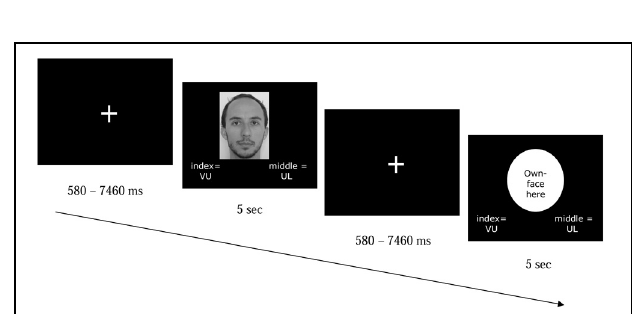
FIGURE 2 | Example of two trials of the task participants performed in the scanner. Participants were presented with a picture of themselves, a familiar other, an ingroup or outgroup member. Although the group names appeared at the bottom of the screen for all picture types (VU = VU University Amsterdam; UL = Leiden University), participants’ task was to respond only when a picture of an ingroup or outgroup members was presented. Target pictures stayed on the screen for 5s, even after participants had